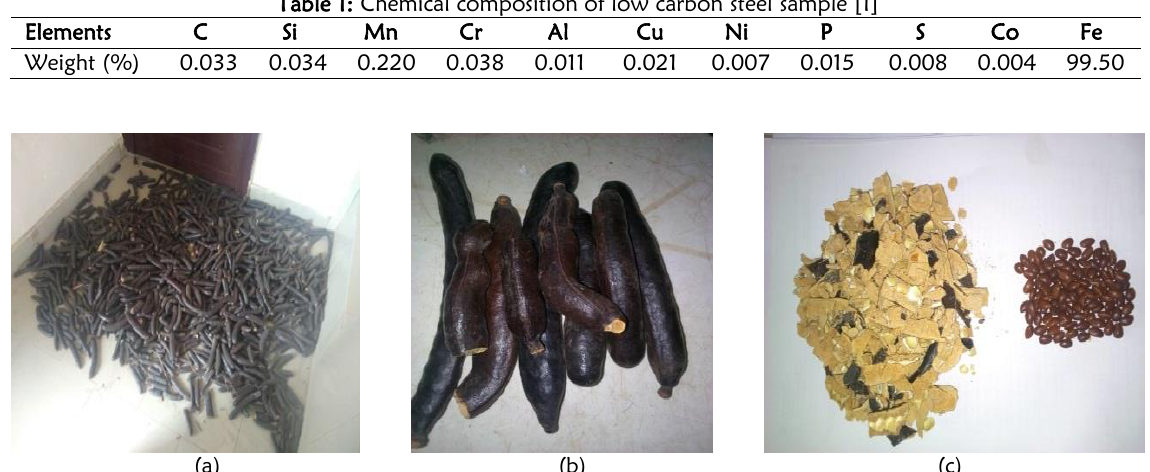
Table 1: Chemical composition of low carbon steel sample [1]